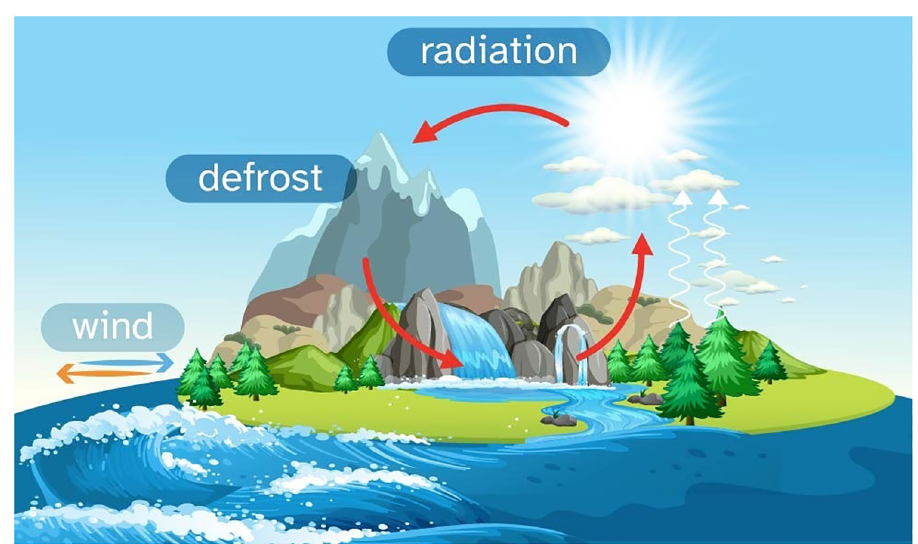
Fig 1. Water cycle sources (solid, liquid and vapor phases). Source: elaborated by the authors.